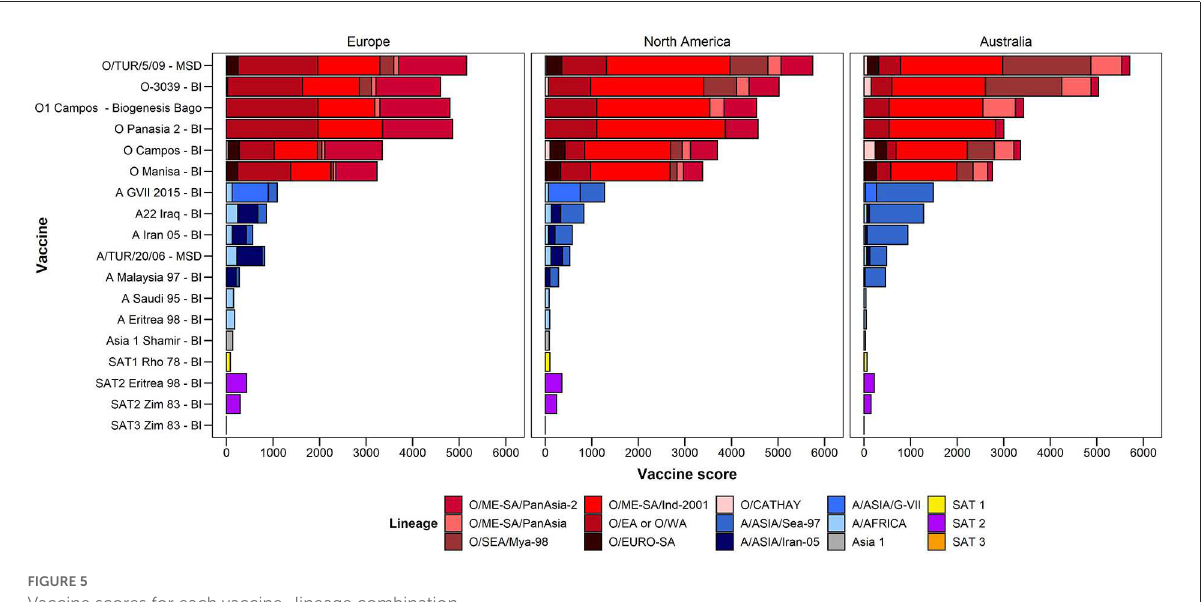
FIGURE5 Vaccine scores for each vaccine–lineage